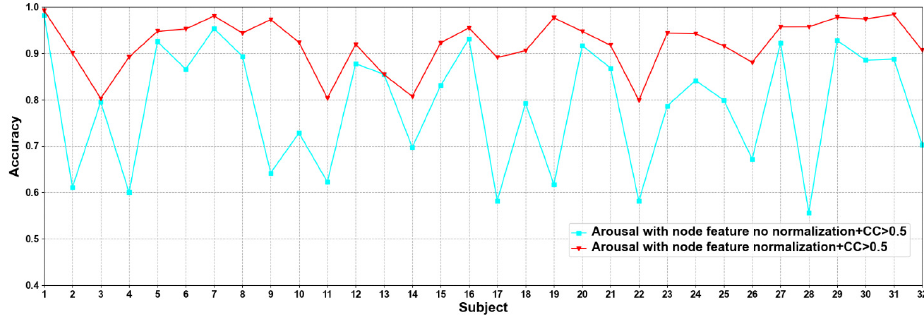
( a ) Arousal with/without node feature normalization with CC > 0.5.